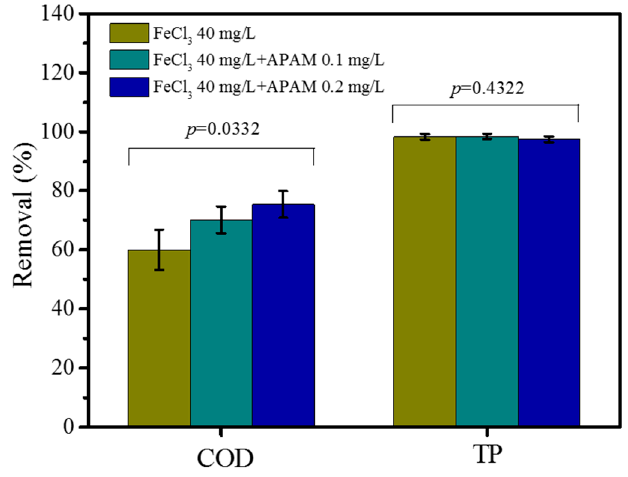
Table 3. The comparison of CEPT’s efficiencies.